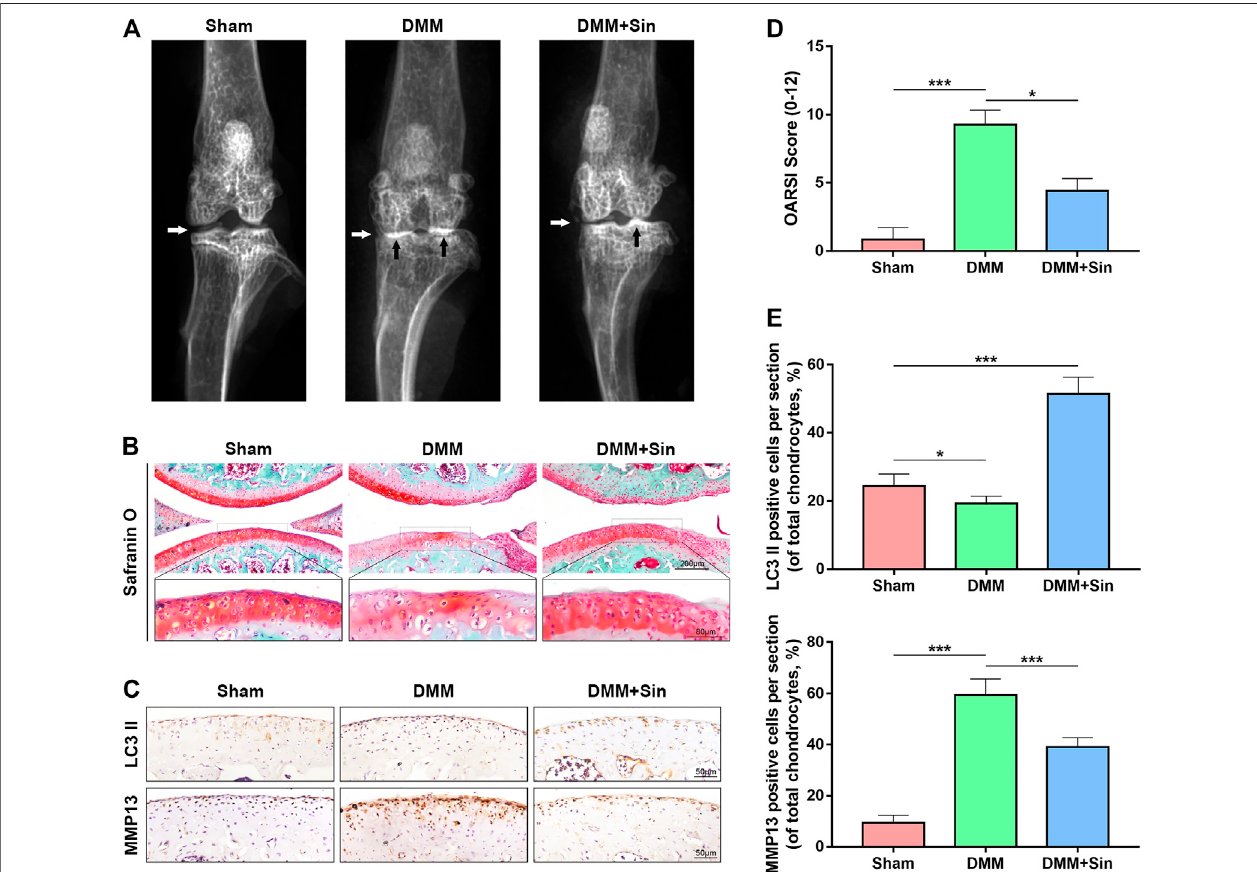
FIGURE7| SinprotectsagainstDMM-inducedOApathogenesis. (A) RepresentativeX-rayimagesofthekneejointsofmiceindifferentexperimentalgroups.White arrows indicate narrowing of the joint space, and black arrows indicate calci fi cation of the cartilage surface. (B) Representative images of cartilage S-O staining in the three groups at 8 weeks postoperatively. (C) Immunohistochemical staining assay of LC3 II and MMP13 in the mouse cartilage (Scale bar: 50 μ m). (D) OARIS scores of articularcartilageinthreegroups. (E) QuantitativeanalysisofLC3IIandMMP13positiveexpressioninsections.Thedataarepresentedasthemeans ± SD( n (cid:1) 10); * p < 0.05, ** p < 0.01, and *** p < 0.001.